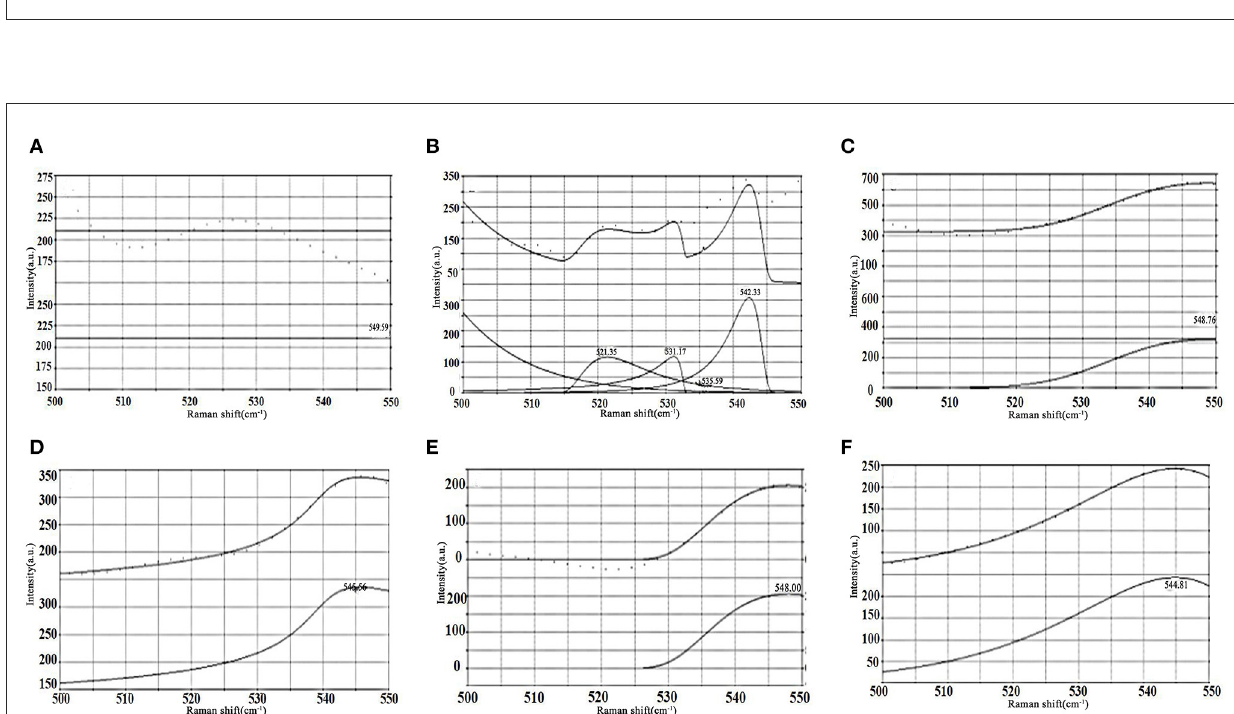
FIGURE2 The characteristic bands of disulfide bond in soybean meal protein distinguish the peaks and fitting curves. (A) 0h. (B) 2h. (C) 4h. (D) 6h. (E) 8h. (F) 10h.